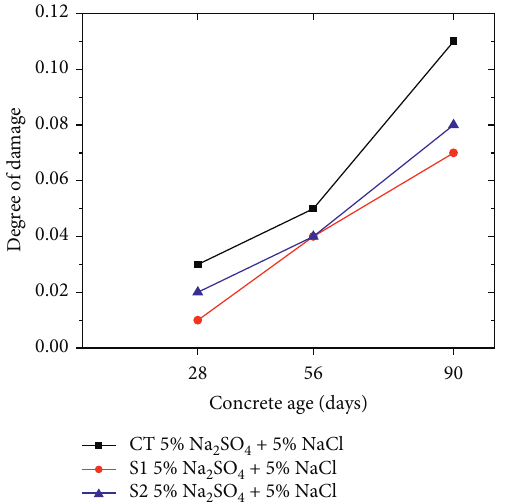
Figure 12: Degree of damage of CT, S1, and S2 immersed in the combined sulphate and chloride solution.